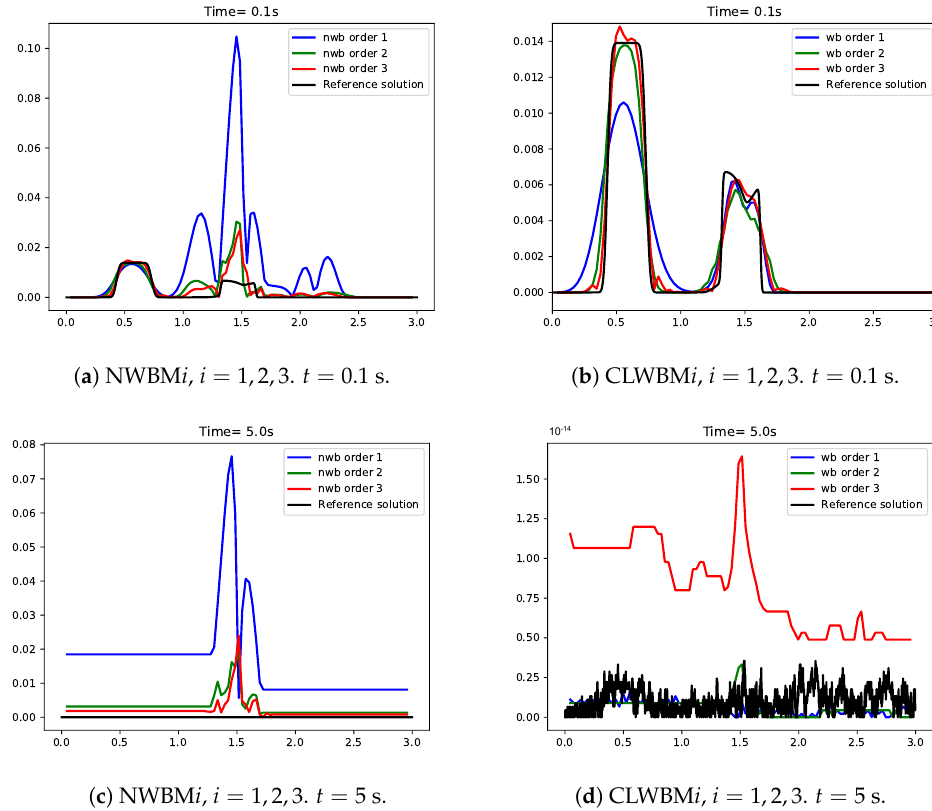
Figure 7. Test 3.3. Reference and numerical solutions: differences with the stationary solution at times t = 0.1 s and t = 5 s for h for a 100-cell mesh.